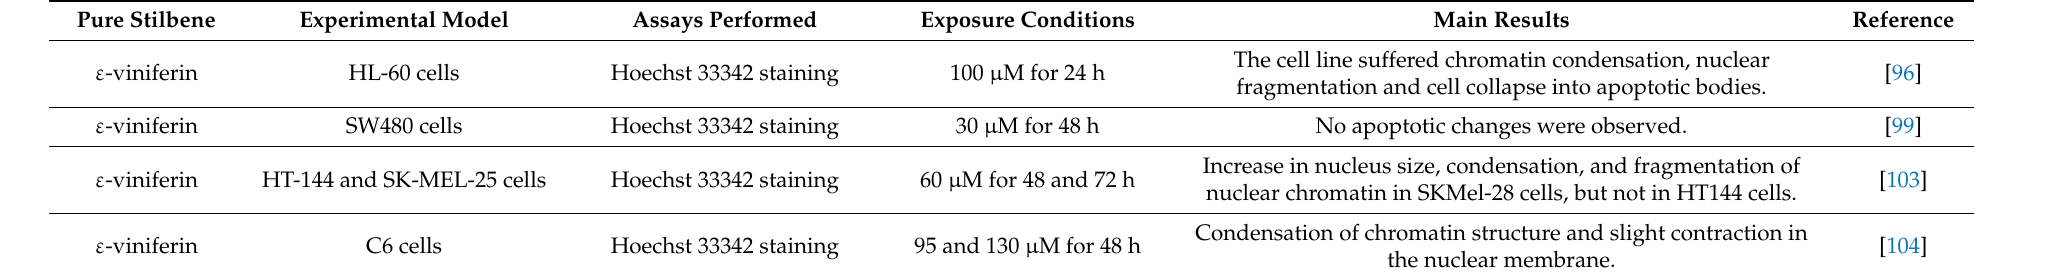
Table 6. In vitro morphological studies performed with ε